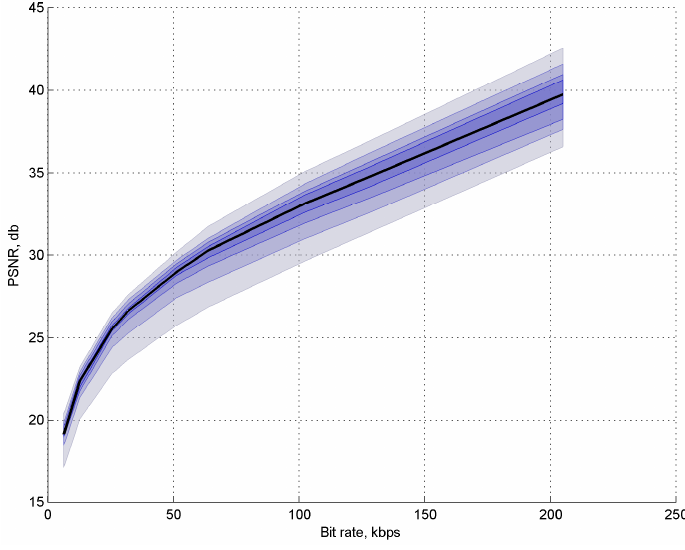
Figure 13. Video quality (Peak Signal to Noise—PSNR) vs video bit rate.